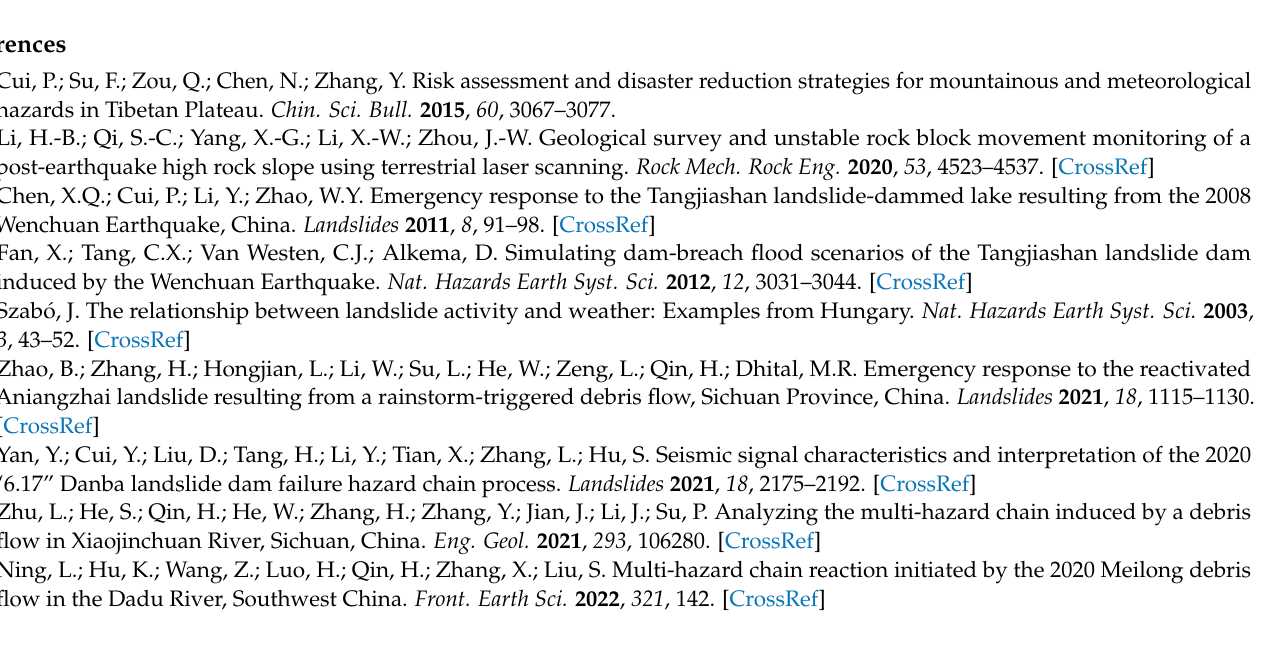
different step sizes. Note that the fixed initial-final window sizes of 64-64 and red band was used.; Figure S5. Corrected horizontal displacement mapped from the PlanetScope image pair between 16 June 2020 and 24 June 2020 using different step sizes with the fixed initial-final window sizes of 64-64 and red band.; Figure S6. Means, standard deviations, and SNR (measurement quality) in the stable area of POT results derived from the PlanetScope image pair between 16 June 2020 and 24 June 2020 with blue, green, red, and NIR bands. Note the fixed initial-final window sizes of 64-64 and a step size of 2 was used. Figure S7. Corrected horizontal displacement mapped from the PlanetScope image pair between 16 June 2020 and 24 June 2020 using different Bands (blue, green, red, and NIR) with the fixed initial-final window sizes of 64-64 and step size of 2.; Figure S8. Horizontal displacement of the whole ancient landslide based on difference of orthophotos collected from the unmanned aerial vehicles (UAVs). (a) Horizontal displacement of the whole ancient landslide in the first month. (b) Horizontal displacement of zone II in the first month. (c) Horizontal displacement of the whole ancient landslide in the second and third months. (d) Local subsidence of zone I. Note that this figure is sourced from [13]; Figure S9. Cross validation based on the differences between the projected vertical displacements from the post-failure descending and ascending InSAR measure- ments.; Figure S10. Relationship between SED, SAD, TB, and uncertainties in the East/West direction and North/South direction after imposing limitations to TB (0 < TB ≤ 200 days, 200 < TB < 360 days, 0 < TB ≤ 100 days, and 0 < TB ≤ 60 days). The red and blue colour indicate the first and second time series POT results, respectively. The circle, square, and triangle markers represent the SED, SAD, and TB, respectively. The black lines represent the best linear fits.; Table S1: Optical images acquired by the PlanetScope satellite for this